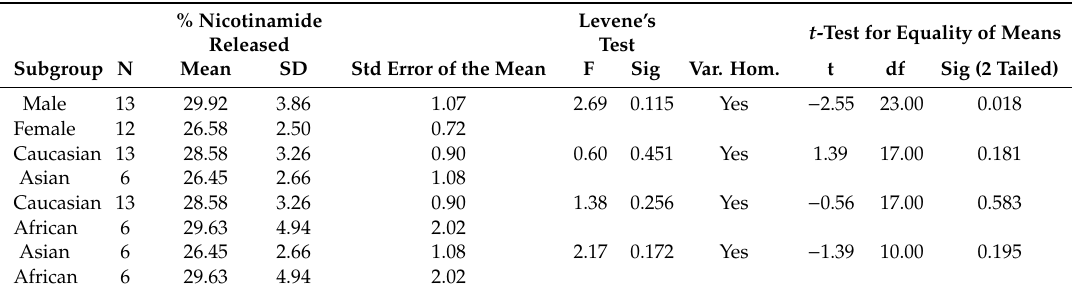
Table 2. Statistical sub-group analysis of residual niacinamide in wipes. % Nicotinamide Released